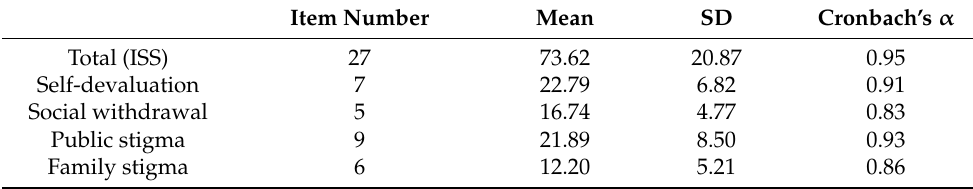
Table 3. Cronbach’s α of the ISS ( N =